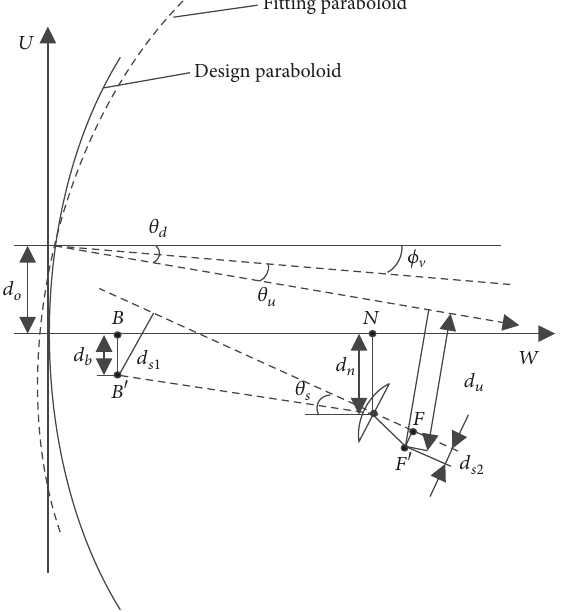
Figure 4: The pointing error caused by reflector